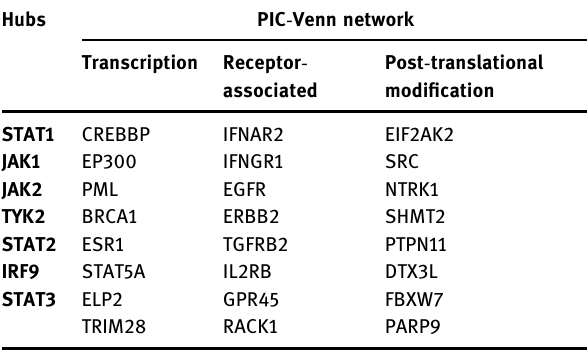
Table 5: Pairwise comparison of STAT1 with other critical hubs and PIC - Venn network in interferon signaling Hubs